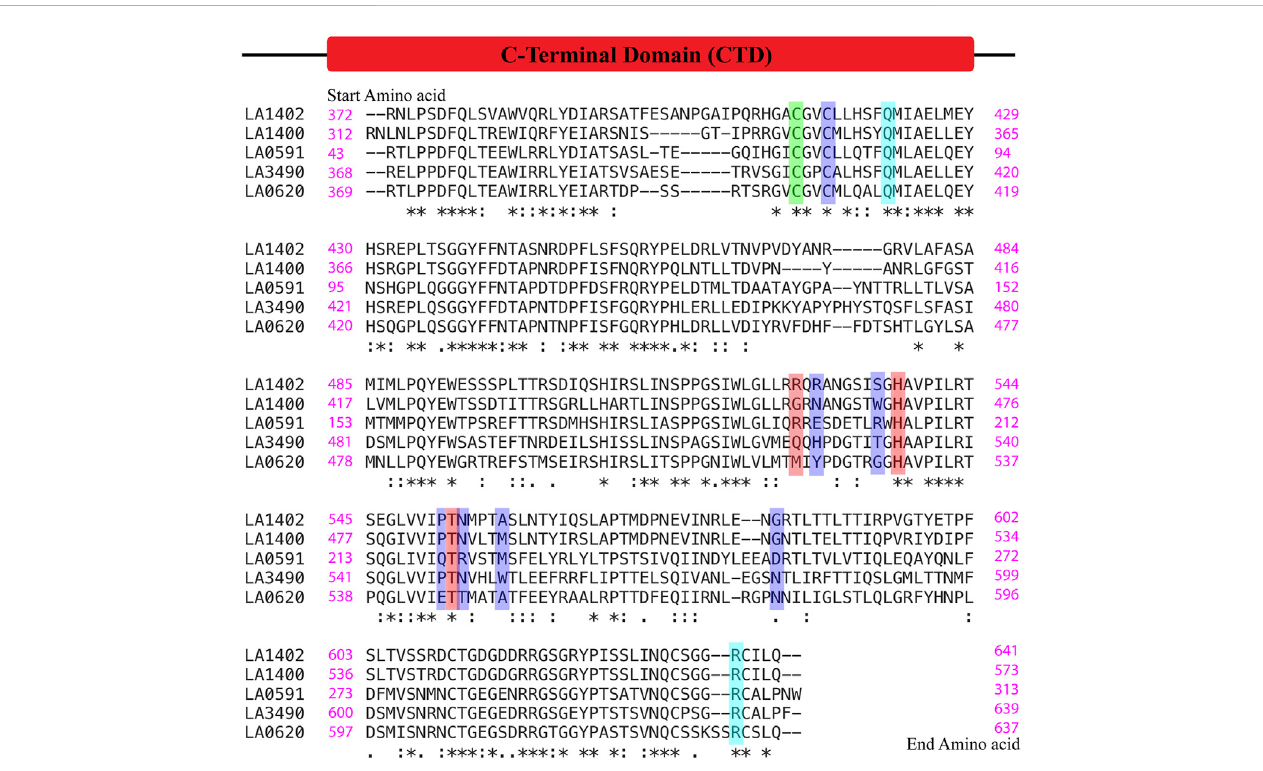
FIGURE 7 Multiple alignment sequence and conservation of hot-spot or ligand binding residues in VM proteins. The sequences of C-terminal domain of VM proteins (LA3490, LA0620, LA1400, LA1402, and LA0591, naturally lacks RBLs) were aligned using the Clustal Omega online server. (https://www.ebi.ac.uk/ Tools/msa/clustalo/). The green color shows the conserved hot-spot residues (Cys403) resultant from FTMap and PrankWeb. The red color shows Gln523, His533 and Thr549 as common hot-spot residues resultant from the FTMap, PrankWeb and DeepSite algorithms. Only His533 and Thr549 was found to beconservedamongtheVMproteins.TheligandbindingresiduessuchasCys406,His525,Thr531,Pro548,Asn550,Trp554,Asn580resultantfromPrankWeb and DeepSite, shown in blue, were not conserved in the VM proteins except Cys406. FTMap-derived high binding residues Arg615, and Gln412 (cyan color) were conserved in the VM proteins and actively participate in docking with phosphate and magnesium